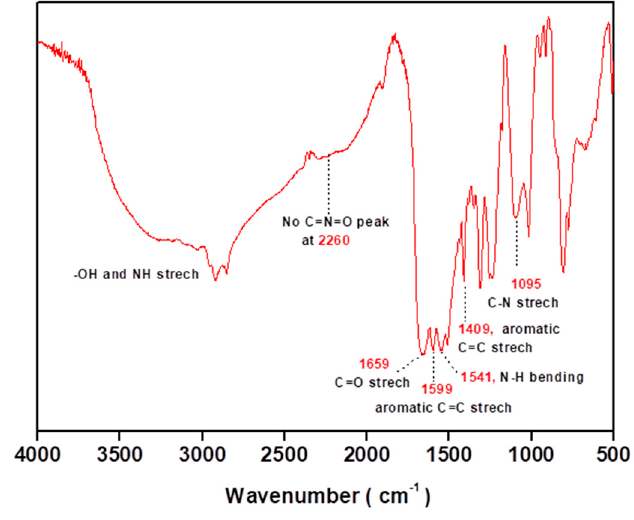
Figure 7. The FTIR spectrum of PU-15.